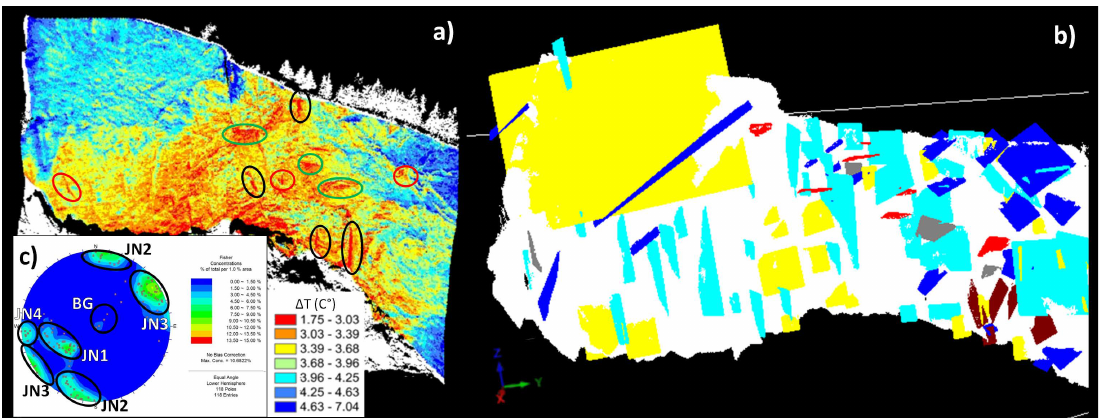
Figure 13. 3D differential surface temperature map highlighting open fractures (black ovals), niches (red ovals) and overhangs (green ovals) ( a ); manual extraction of discontinuity set on high resolution 3D surface ( b ) and resulting stereographic projection ( c ).